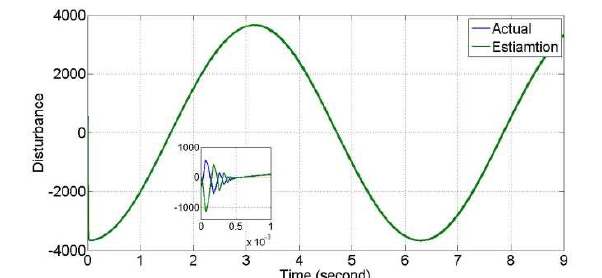
under (cid:157) (cid:158) Fig. 20. Closed loop parametric uncertainties with desired sinusoidal